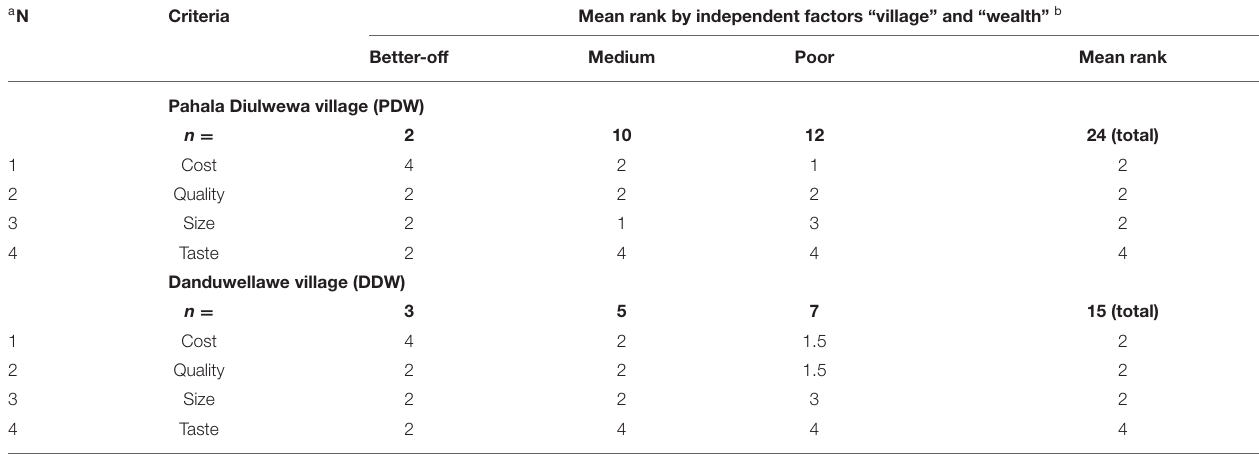
n = number of respondents. a n = mean rank order of all responses by village i.e. without significance testing; 1 indicates greatest preference.